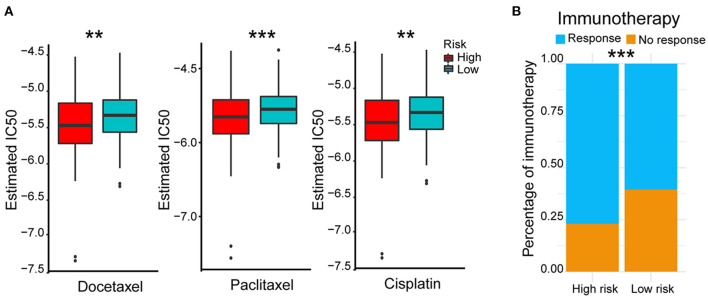
Therapeutic outcomes of the high- and low-risk groups based on the five-AR-lncRNA signature. (A) Sensitivity to different chemotherapeutic drugs, docetaxel (left), paclitaxel (middle) and cisplatin (right), in the high- and low-risk groups. p-values were obtained via Wilcoxon rank sum test. (B) Response to immunotherapy in the high- and low-risk groups. p-values were obtained via Fisher exact test. **p < 0.01 and ***p < 0.001, respectively.